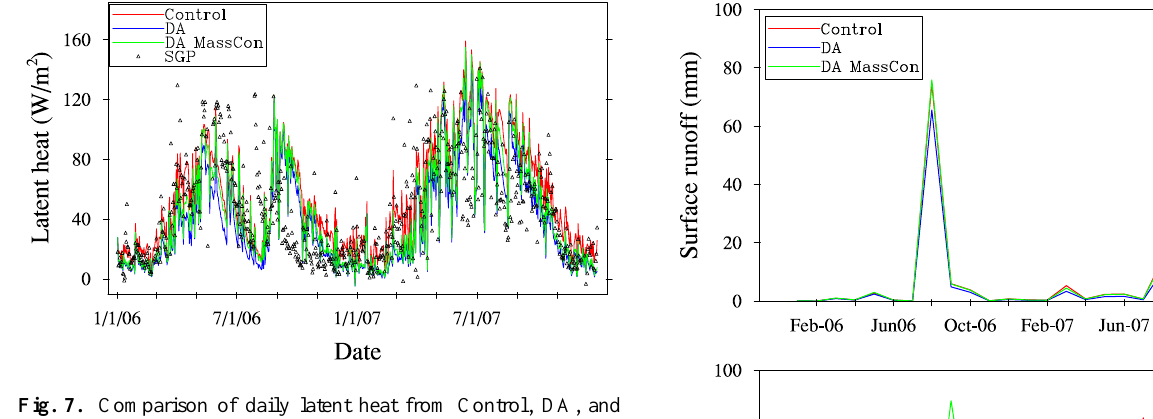
Fig. 7. Comparison of daily latent heat from Control, DA, and DA MassCon versus the SGP flux data. The daily latent heat es- timates are averaged values from 06:00a.m. to 06:00p.m.LT (local time) for both the SGP measurements and Noah estimates.